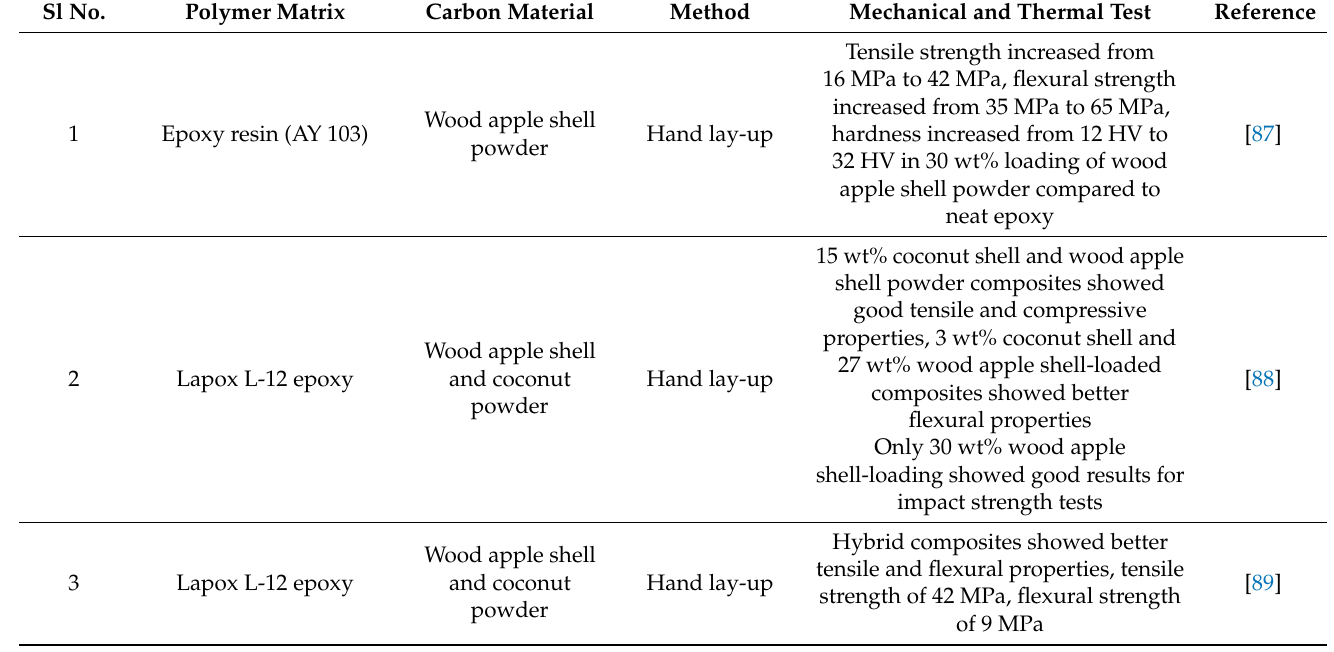
Table 5. Synthesis and characterization of wood apple shell composites.